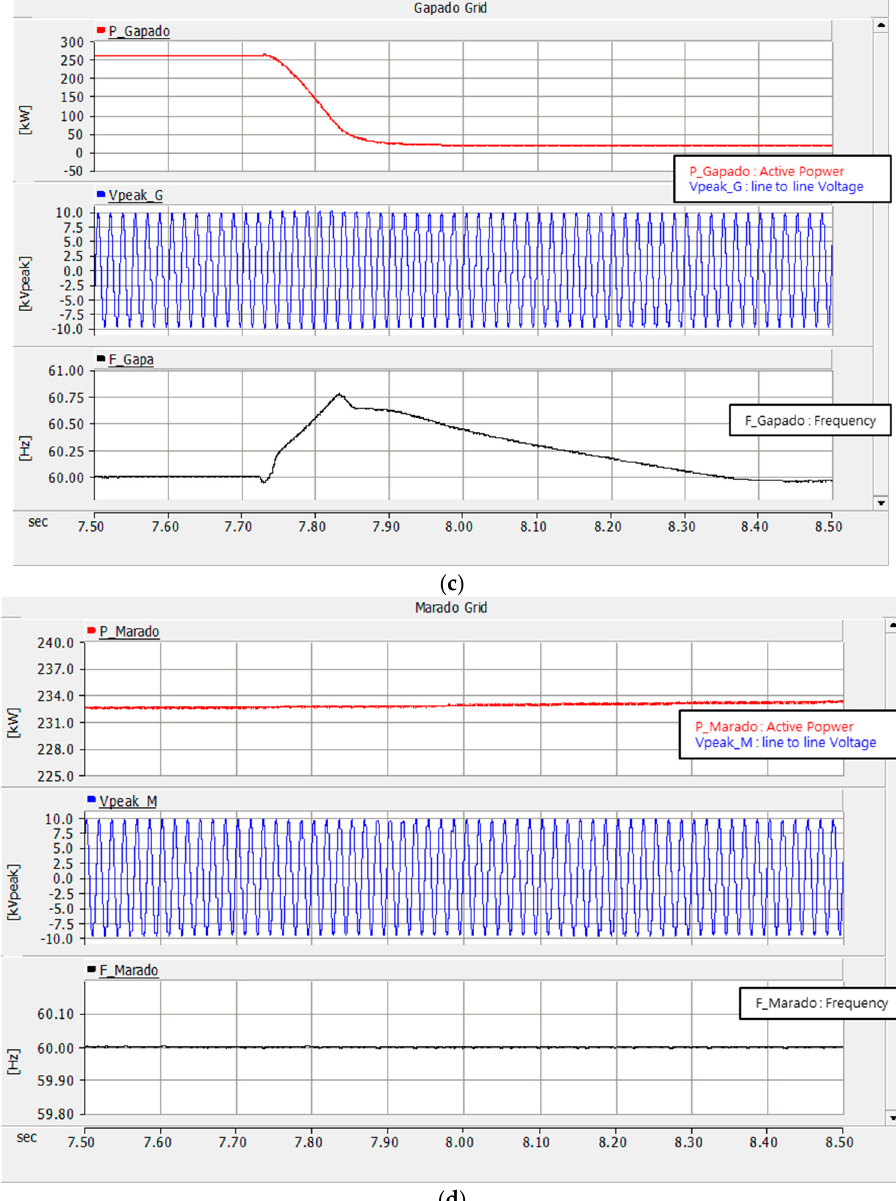
Figure 15. ( a ) Active power; ( b ) Variation of active power of diesel generator; ( c ) Gapado Island power grid; ( d ) Marado Island power grid; through the Wind power penetration.